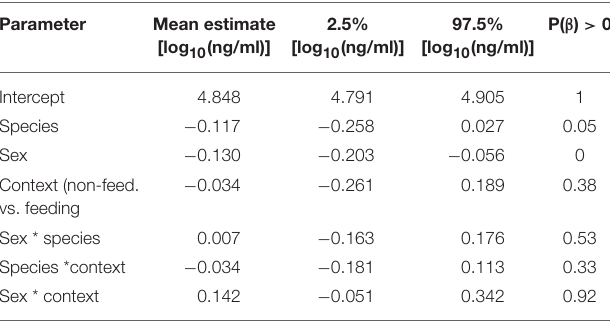
TABLE 2 | Estimates of effect sizes and the 95% credible intervals of the posterior distribution of stress-induced corticosterone concentrations. Parameter